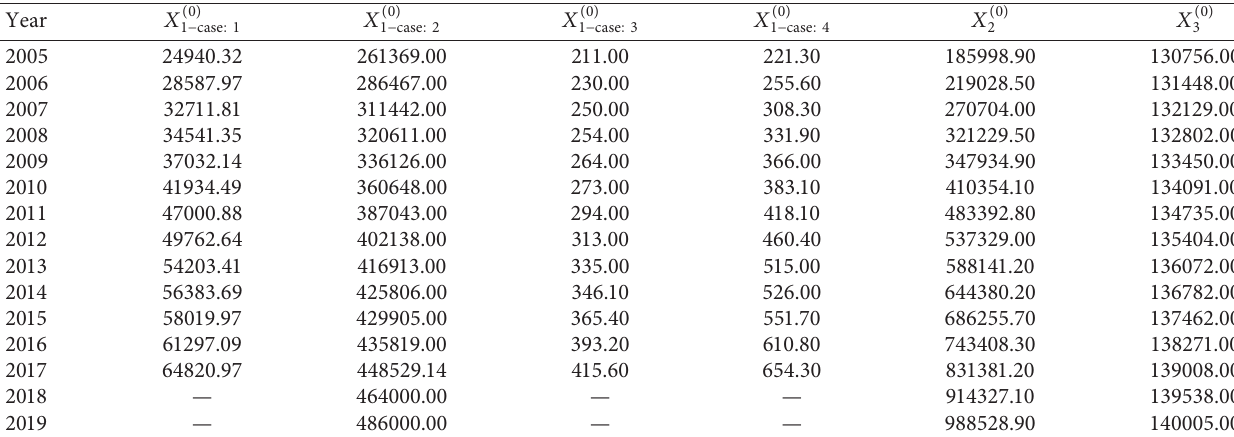
) (10 2 million kilowatt hours), national energy consumption ( X ( 0 ) 1 − case : 1 ) (kg standard coal), per capita living electricity consumption 1 − case : 3